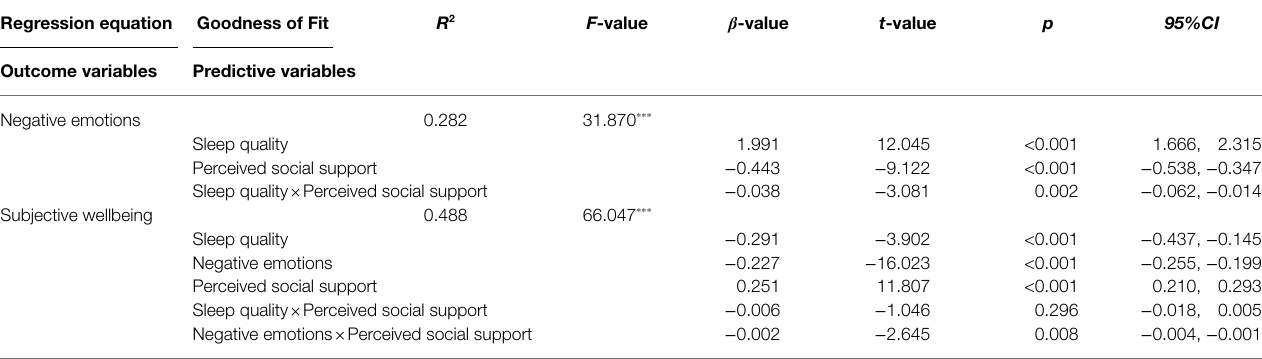
TABLE 4 | Mediating effect analysis with moderation.